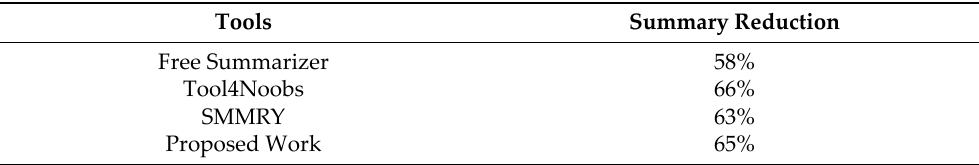
Table 11. Summary comparison among tools.